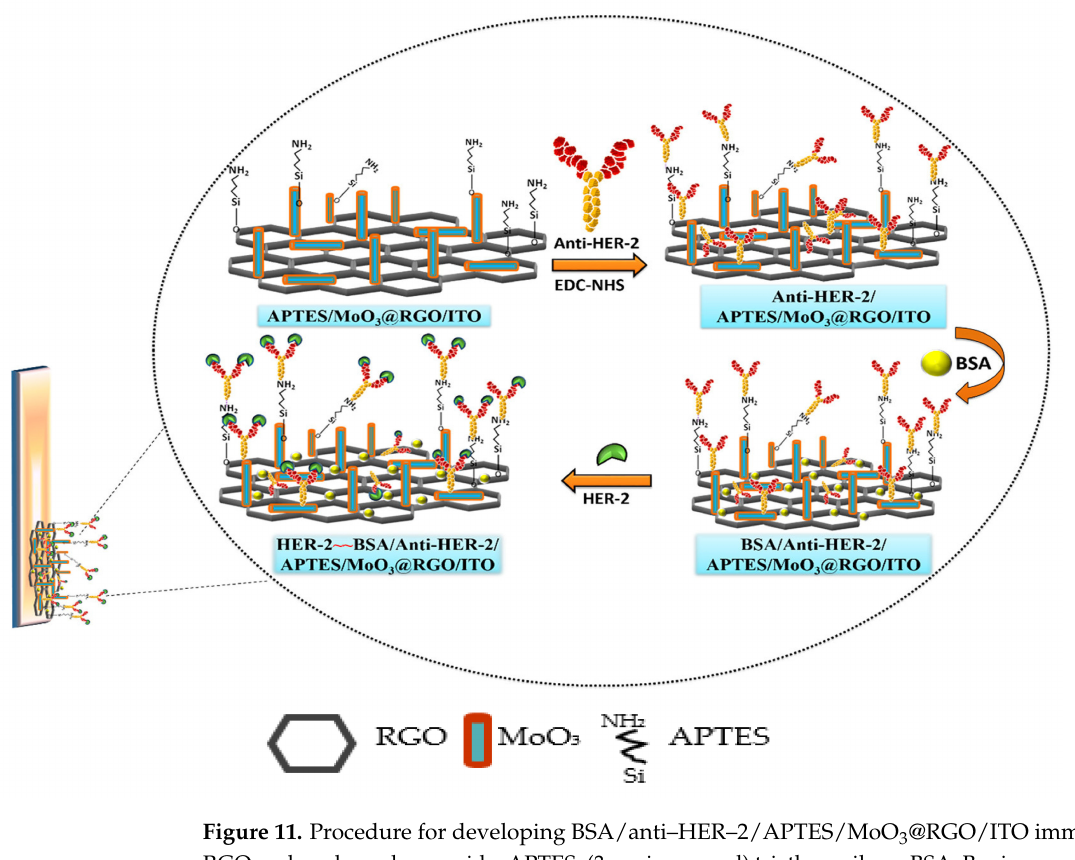
Figure 11. Procedure for developing BSA/anti–HER–2/APTES/MoO 3 @RGO/ITO immunosensor. RGO: reduced graphene oxide; APTES: (3–aminopropyl) triethoxysilane; BSA: Bovine serum albumin; ITO: indium tin oxide electrode; MoO 3 @RGO: graphene oxide doped with molybdenum trioxide. Reprinted with permission from [94], published by American Chemical Society, 2019.